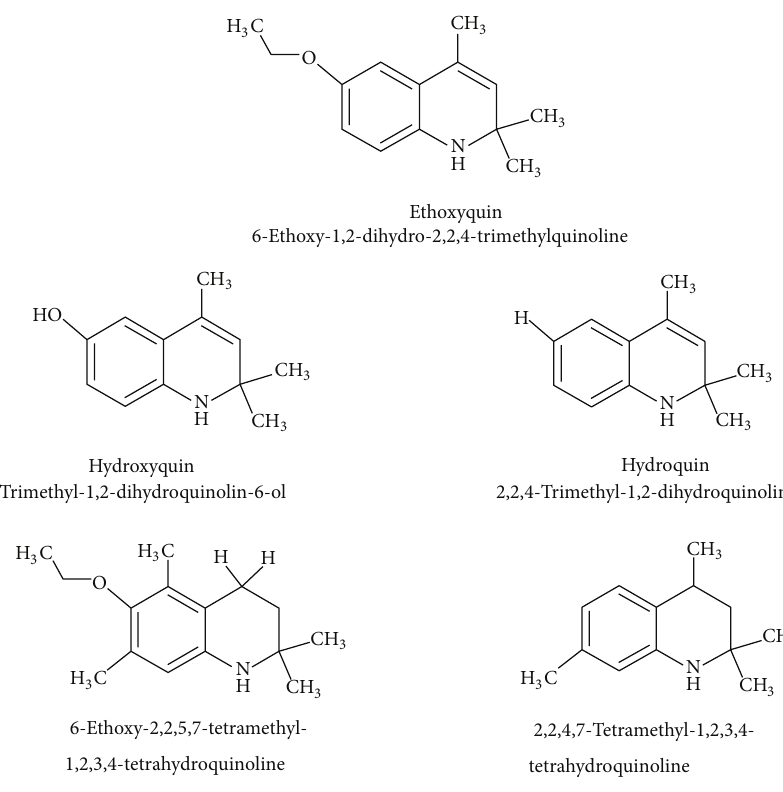
Figure 1: Chemical structure of ethoxyquin (EQ) and of some new compounds synthesized on ethoxyquin backbone with promising antioxidant properties (according to de Koning [12], Dorey et al. [15] and Błaszczyk and Skolimowski